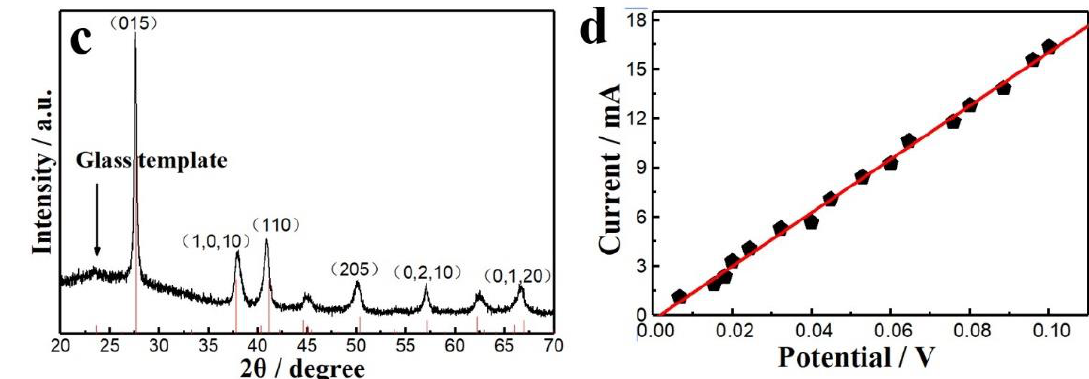
Figure 12. ( a , b ) The morphologies and elemental distributions at different locations in a single micro- column. ( c ) XRD pattern of the glass template filled with TE micro-columns. ( d ) The current vs. voltage curve of a single micro-column via a two-probes method on the micro-probe platform.